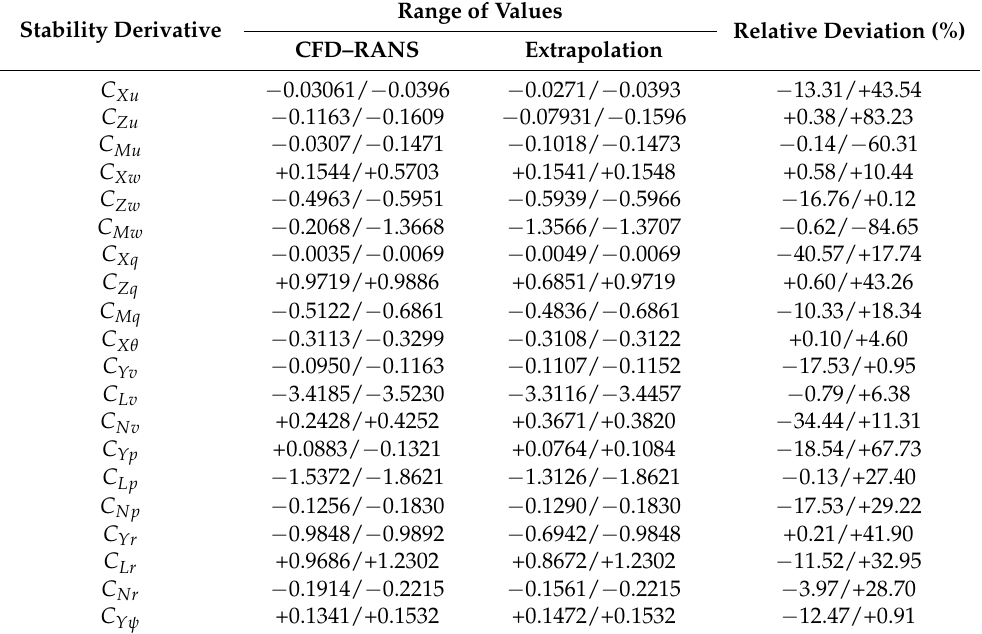
Table 36. Comparison of extrapolation with CFD–RANS (takeoff).